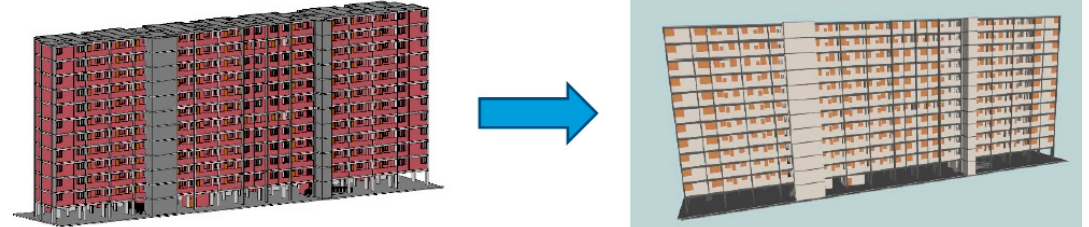
Figure 5. Example of IFC model ( left ) to CityGML LOD2.3 model ( right ).